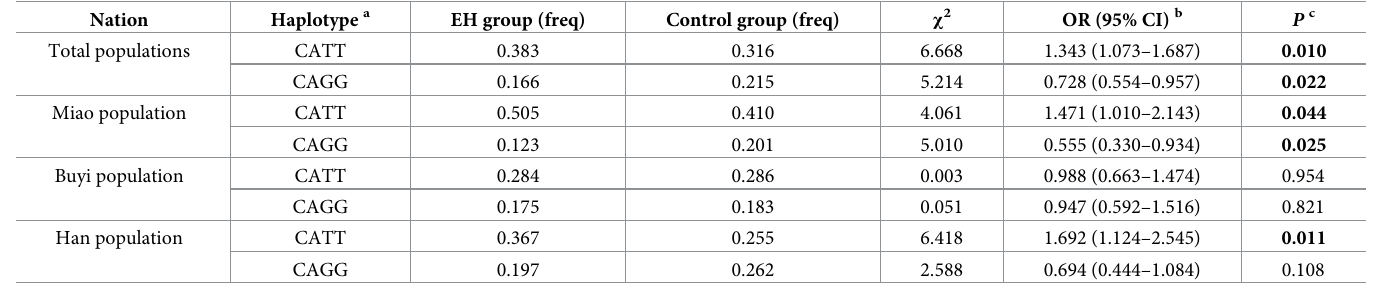
Table 5. Haplotype association analysis between EH group and control group in Guizhou